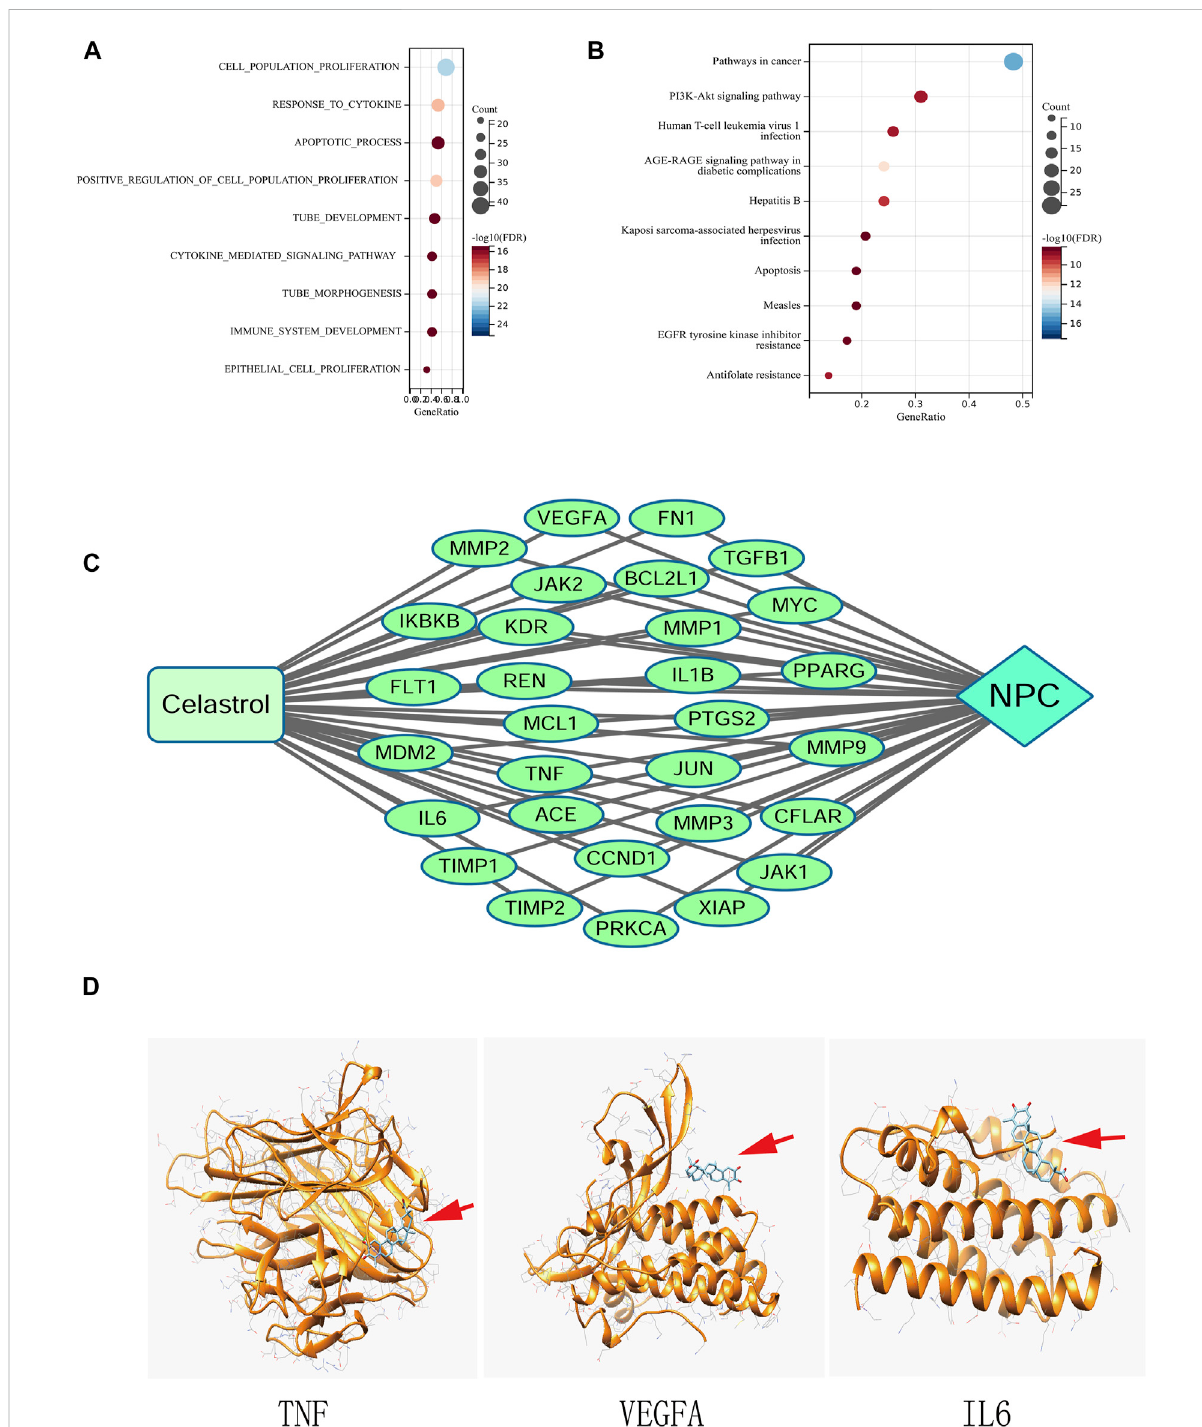
FIGURE 3 (A) GO analysis of the genes common to Celastrol and NPC. (B) KEGG pathway enrichment analysis. (C) The Compound-Target-Disease network. (D) Molecular docking between Celastrol and the top three hub genes (TNF, VEGFA, and IL6). The red arrows indicated the locations of Celastrol. The ribbons represented the 3D structures of the